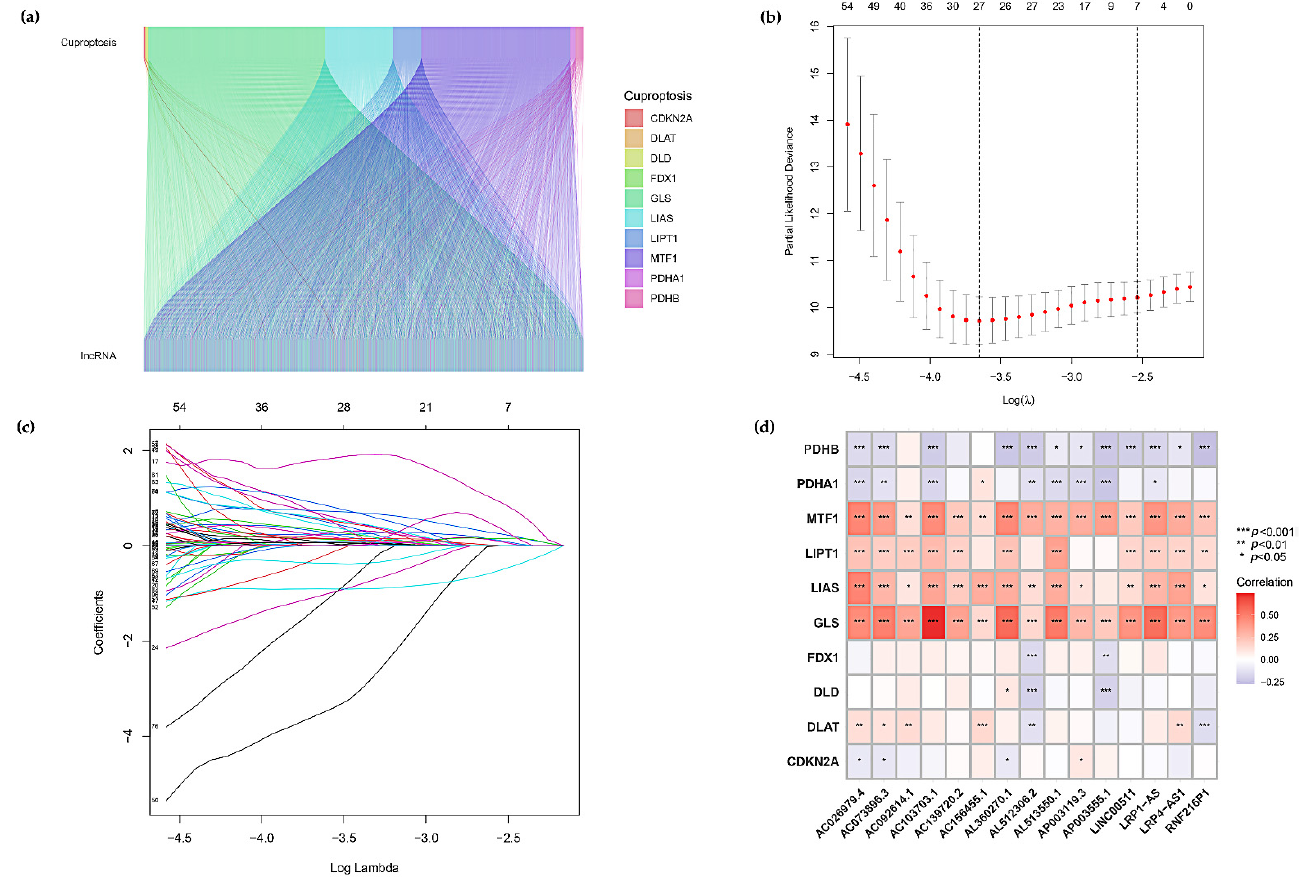
Figure 2. Screening for Prognostic lncRNA Signature. ( a ) Co-expression analysis of lncRNAs associated with cuproptosis-related genes in COAD. ( b , c ) The least absolute shrinkage and selection operator (LASSO) regression was performed with the minimum criteria. ( d ) Correlation analysis of 15 signature lncRNAs with 10 cuproptosis-related genes (horizontal coordinates are lncRNAs involved in model construction, blue represents negative correlation, red represents positive correlation).